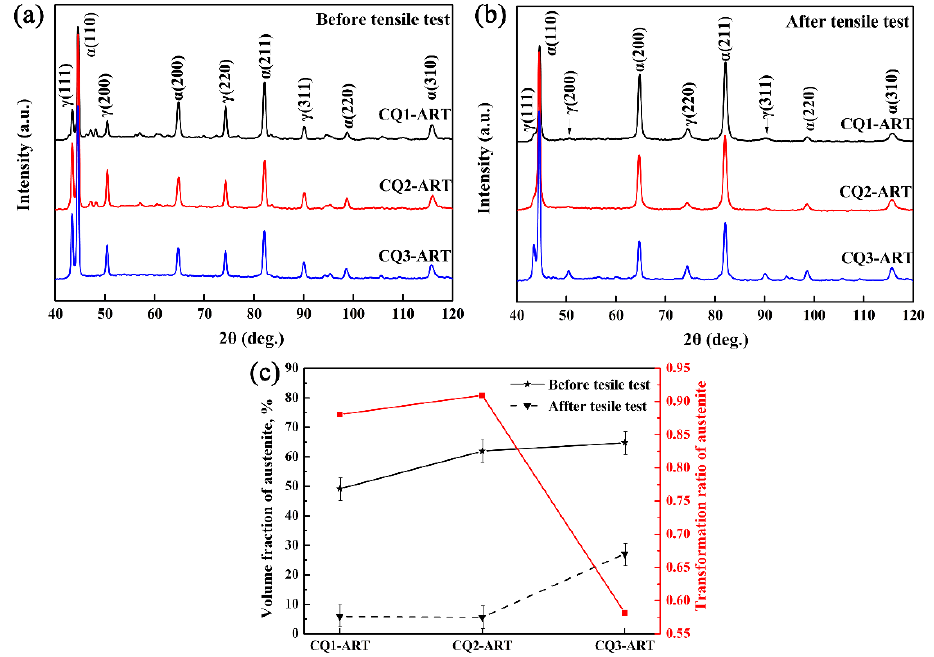
Figure 3. XRD characterization of experimental steel: ( a , b ) XRD patterns and ( c ) measured austenite fractions and transformation ratio of austenite.